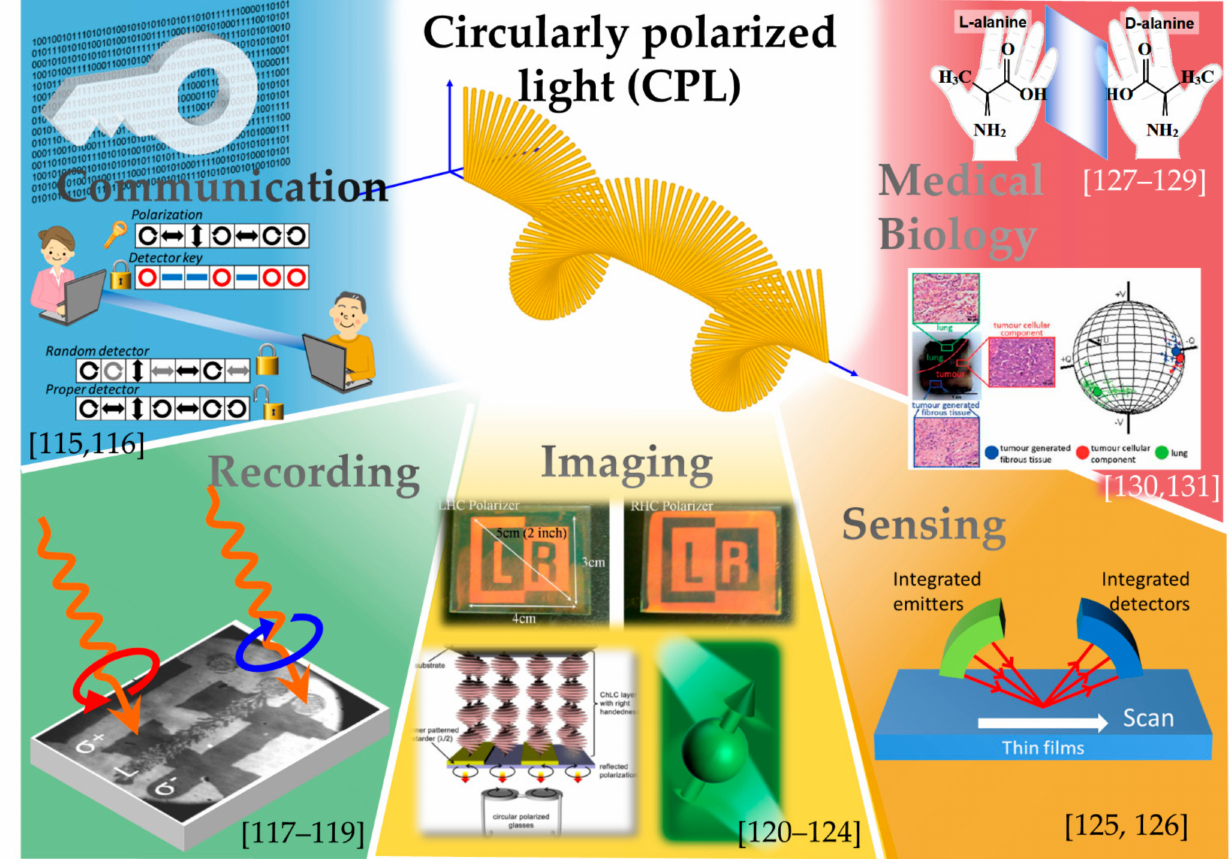
Figure 9. Proposed applications using CPL: (Counterclockwise from upper left) Cryptography in communication [115,116], light source for writing on magnetic media [117–119], 3D display and holography in imaging [120–124], scanning ellipsometry with CPL [125,126], and optical isomer separation and cancer diagnosis in medicine and biology [127–131]. Reproduced with permission from [118] and